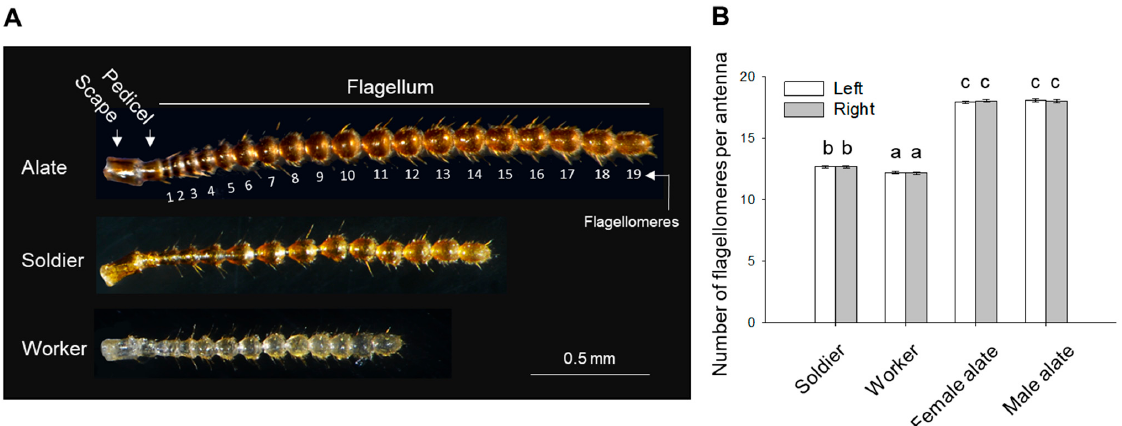
Figure 1. Overall antennal morphology in C. formosanus . ( A ) Representative images of antennae from a female alate, a soldier, and a worker. The antenna is divided into three main regions: scape, pedicel, and flagellum, which is composed of flagellomeres numbered from the proximal to distal end, as exemplified in the alate. ( B ) Numbers of flagellomeres on the left and right antennae in soldiers, workers, female and male alates. Bars represent mean ± standard error (SE). Groups denoted with the same letter are not significantly different (generalized linear mixed model (GLMM), p > 0.05; n = 30 for soldiers and workers, n = 29 for female alates, n = 25 for male alates).